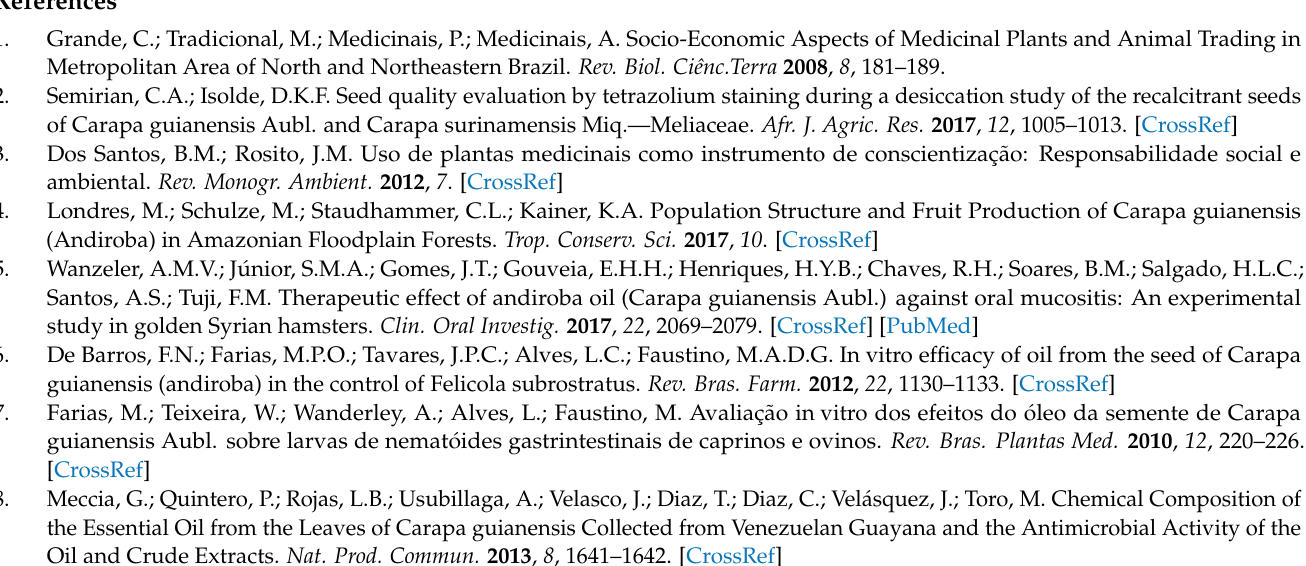
S1(i) volume parameters, and S1(j) to S1(m) volume parameters for S50, S20, and S10, respectively, Figure S2: Representation of the surface texture directions of the more relevant analyzed samples for (a) S50, (b) S20, and (c) S10, Figure S3: Lacunarity distribution of AFM topographic maps with sizes of (a) 50 × 50 µ m (S50), (b) 20 × 20 µ m (S20), and (c) 10 × 10 µ m